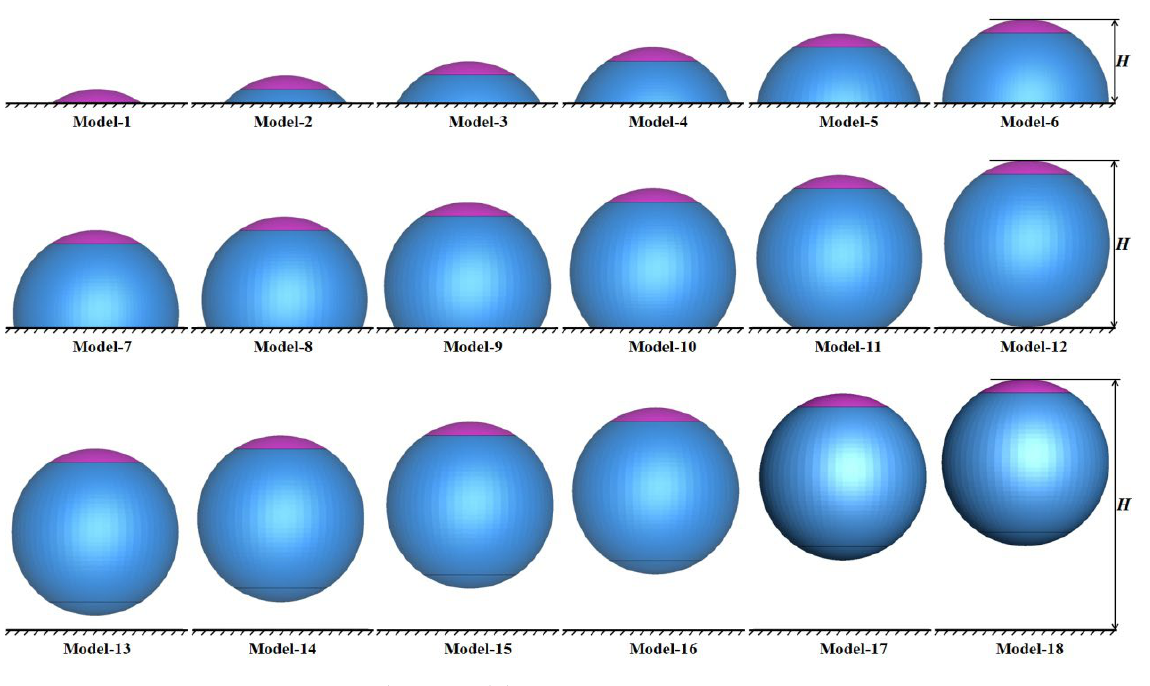
Figure 3. Simulation models. Table 1. Details of the simulation cases. Table 1. Details of the simulation